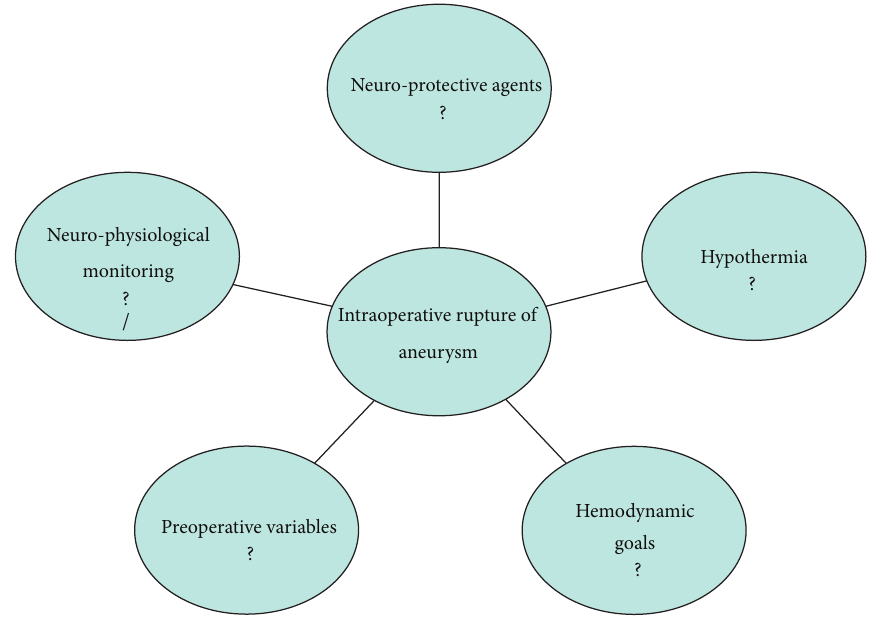
Figure 1: Controversial issues related to the management of